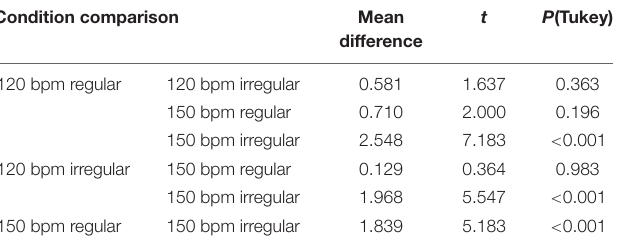
TABLE 3 | Post hoc Tukey t -test comparing differences in performance across all conditions. Condition comparison